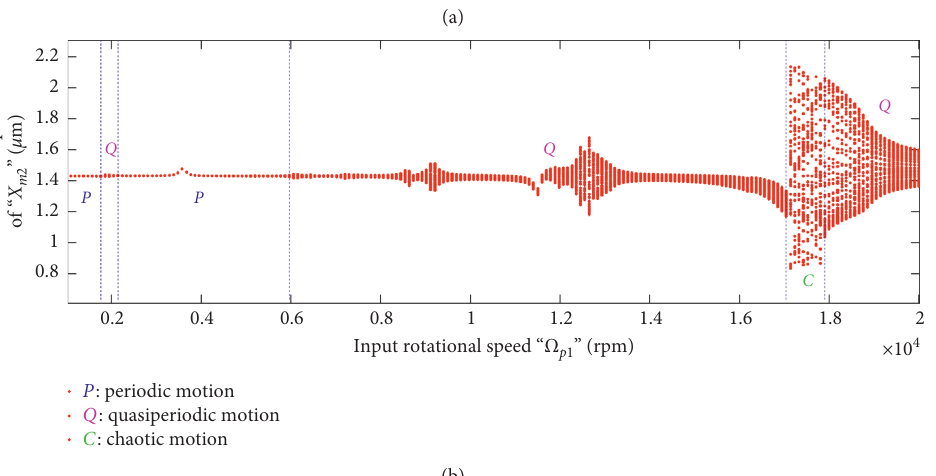
Figure 3: Backward bifurcation diagrams of system using Ω